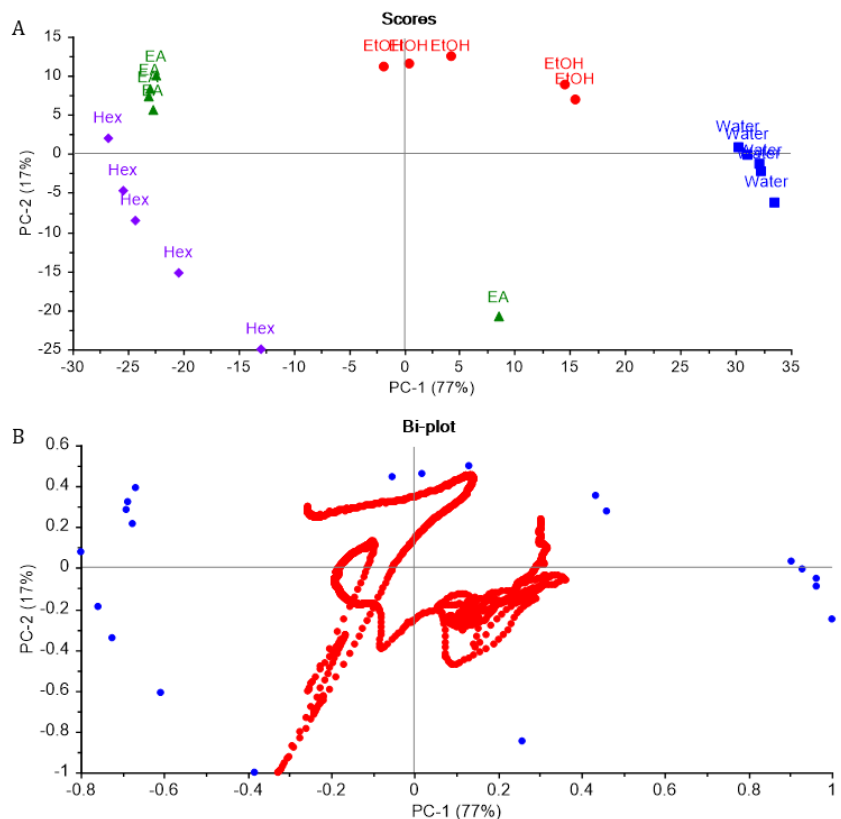
Figure 2. The score plot (A) and loading plot (B) of PCA derived from extract of G. ulmifolia leaves using variable mid-IR area (4000-400 cm -1 ) ( ● = ethanol, ■ = water,  = n -hexane, ▲ = ethyl